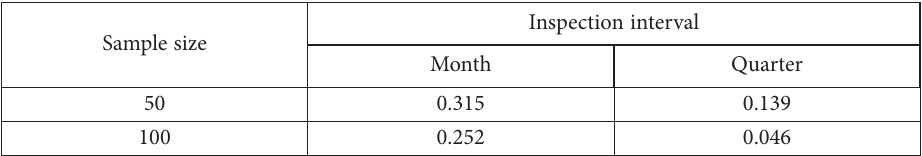
Table 11. Comparison of P values with different sample sizes (weight restriction is 0.05)